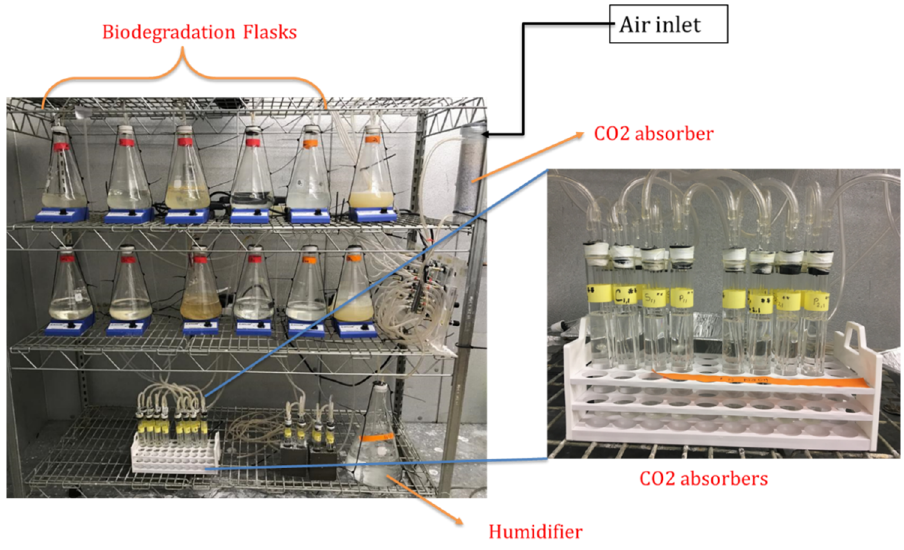
Figure 17. Experimental aqueous biodegradation setup. The average % biodegradation curves for cellulose and PLA and PLA + 5% MTPS at 30 ◦ C are as shown in Figure 18.